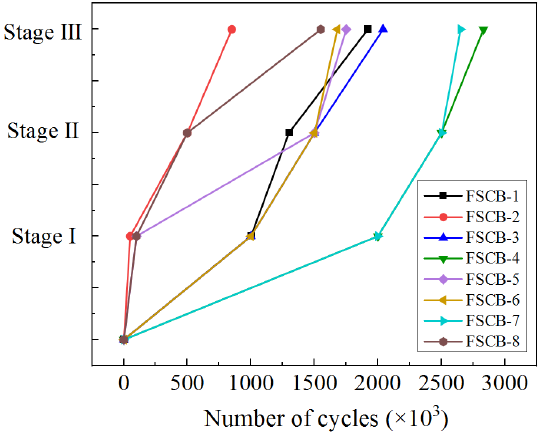
Figure 7. Order of fatigue damage